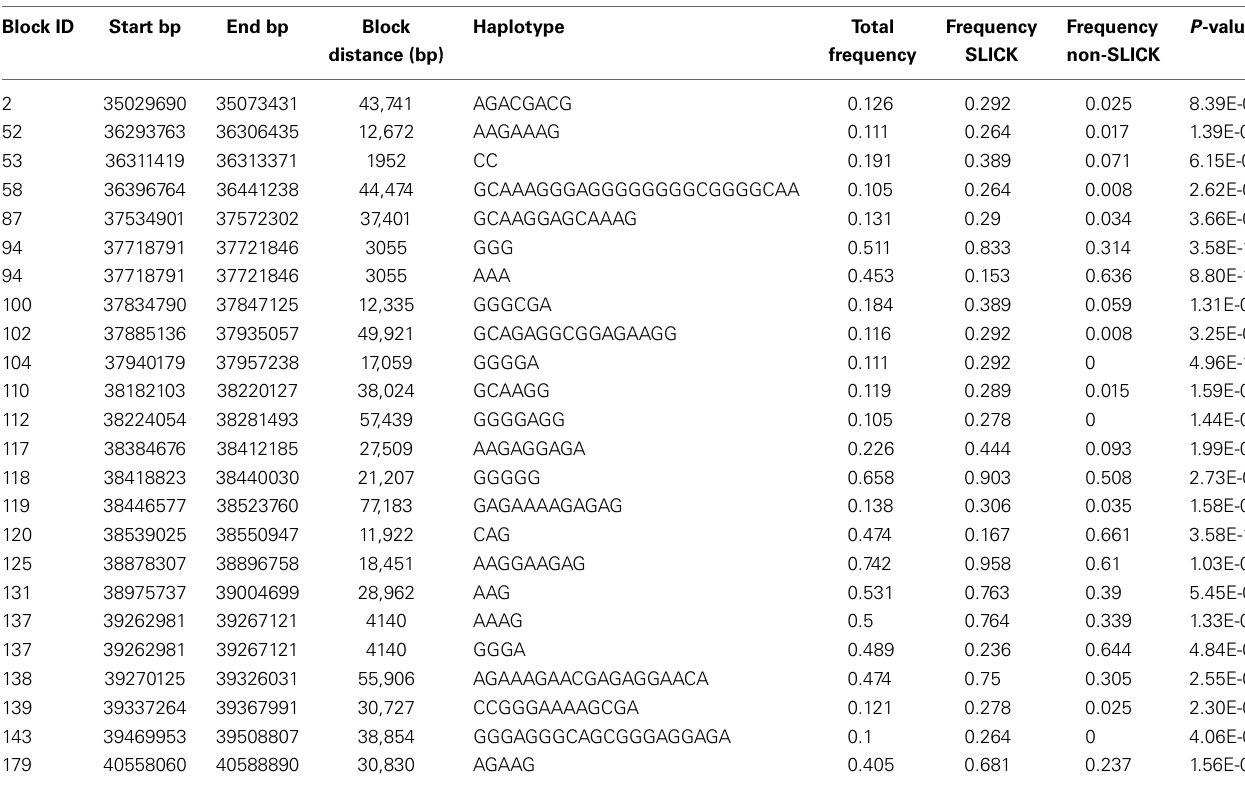
Table 2 | The 24 most highly associated haplotype patterns on BTA20 for the slick/non-slick phenotype were identified and given a Block ID. Block ID